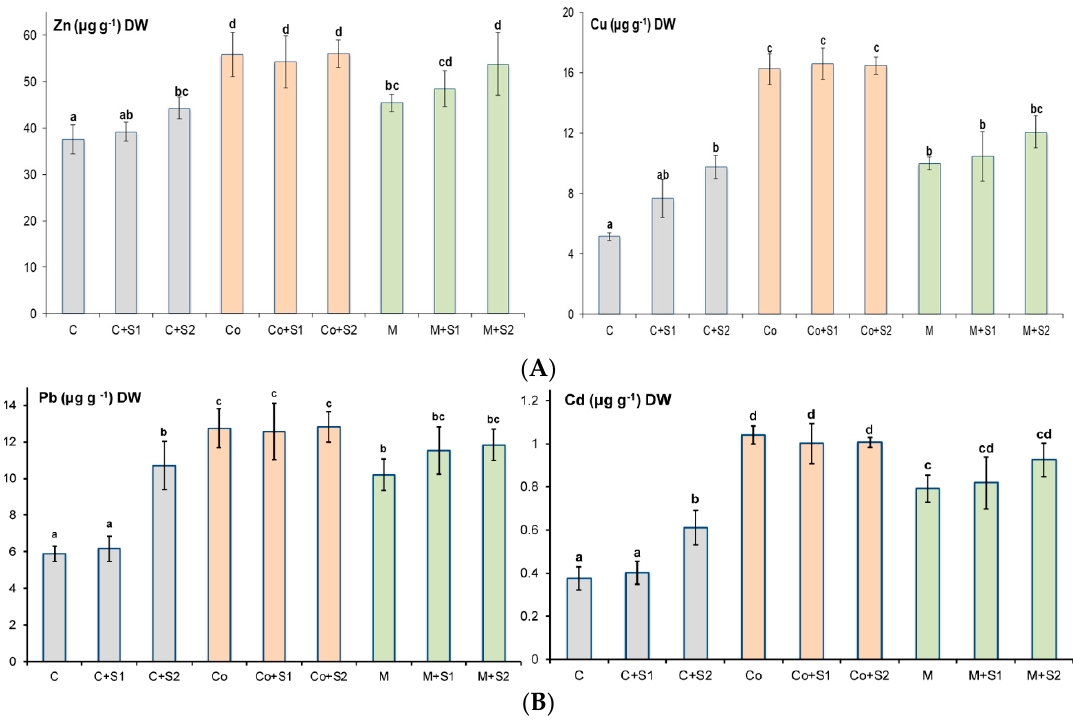
Figure 3. ( A ) Zinc (Zn) and copper (Cu) concentrations (µg g − 1 DW) in alfalfa shoots grown for six months on clay soils with or without MSW Compost (Co) or farmyard manure(M) application and irrigated water containing 0 mM, 50 mM (S1), 100 mM (S2) NaCl. Data are means of six repeats ± SE. The different letters ( abcd ) represent a significant difference between treated samples. p < 0.05 by Duncan’s multiple range test. ( B ) Lead (Pb) and cadmium (Cd) contents (µg g − 1 DW) in the shoots of alfalfa grown for six months on soil with or without the addition of MSW Compost (Co) or farmyard manure (M) and irrigated water with 0 mM, 50 mM (S1), 100 mM (S2) NaCl. Data are means of six repeats ± SE. The different letters ( abcd ) represent a significant difference between treated samples. p < 0.05 by Duncan’s multiple range test.